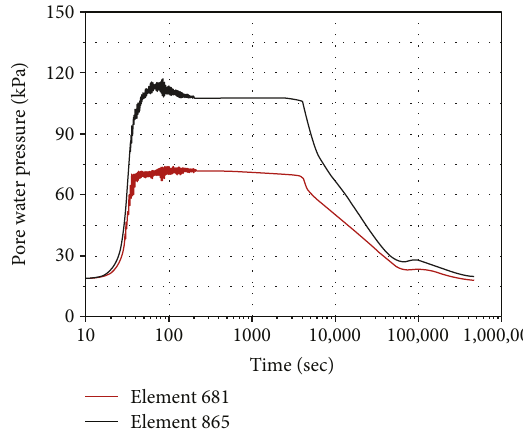
Figure 29: Dissipation of excess pore water pressure for element 681 and element 865 during consolidation.